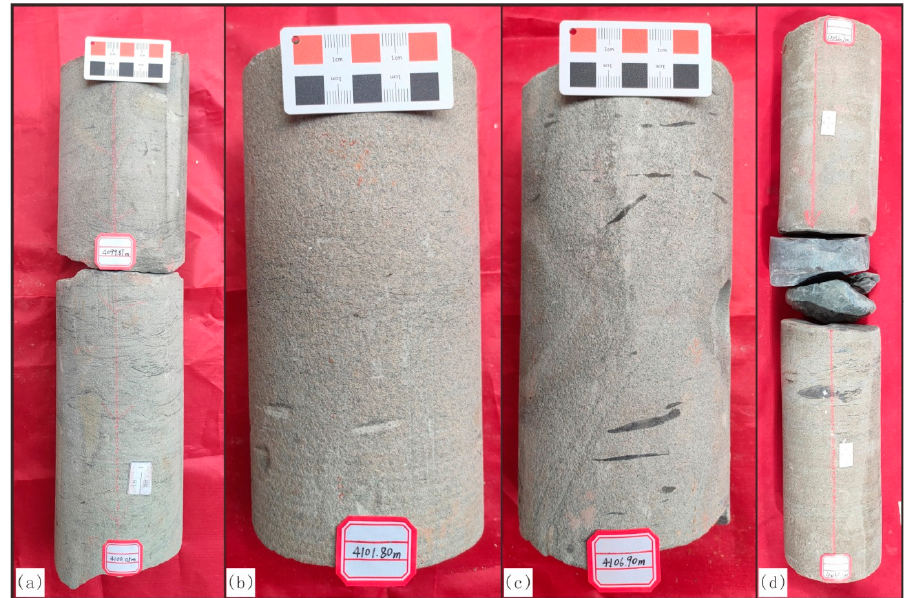
Figure 5. Typical sedimentary structure of the upper part microfacies of the single sandy debris flow deposition cycle. ( a ) Well QS7, 4100.05 m, the deformation of argillaceous lamina or carbonaceous layer; ( b ) Well QS7, 4101.08 m, massive sandstone; ( c ) Well QS7, 4106.90 m, scour surface structure; ( d ) Well QS202, 4032.70 m, top mutation structure.